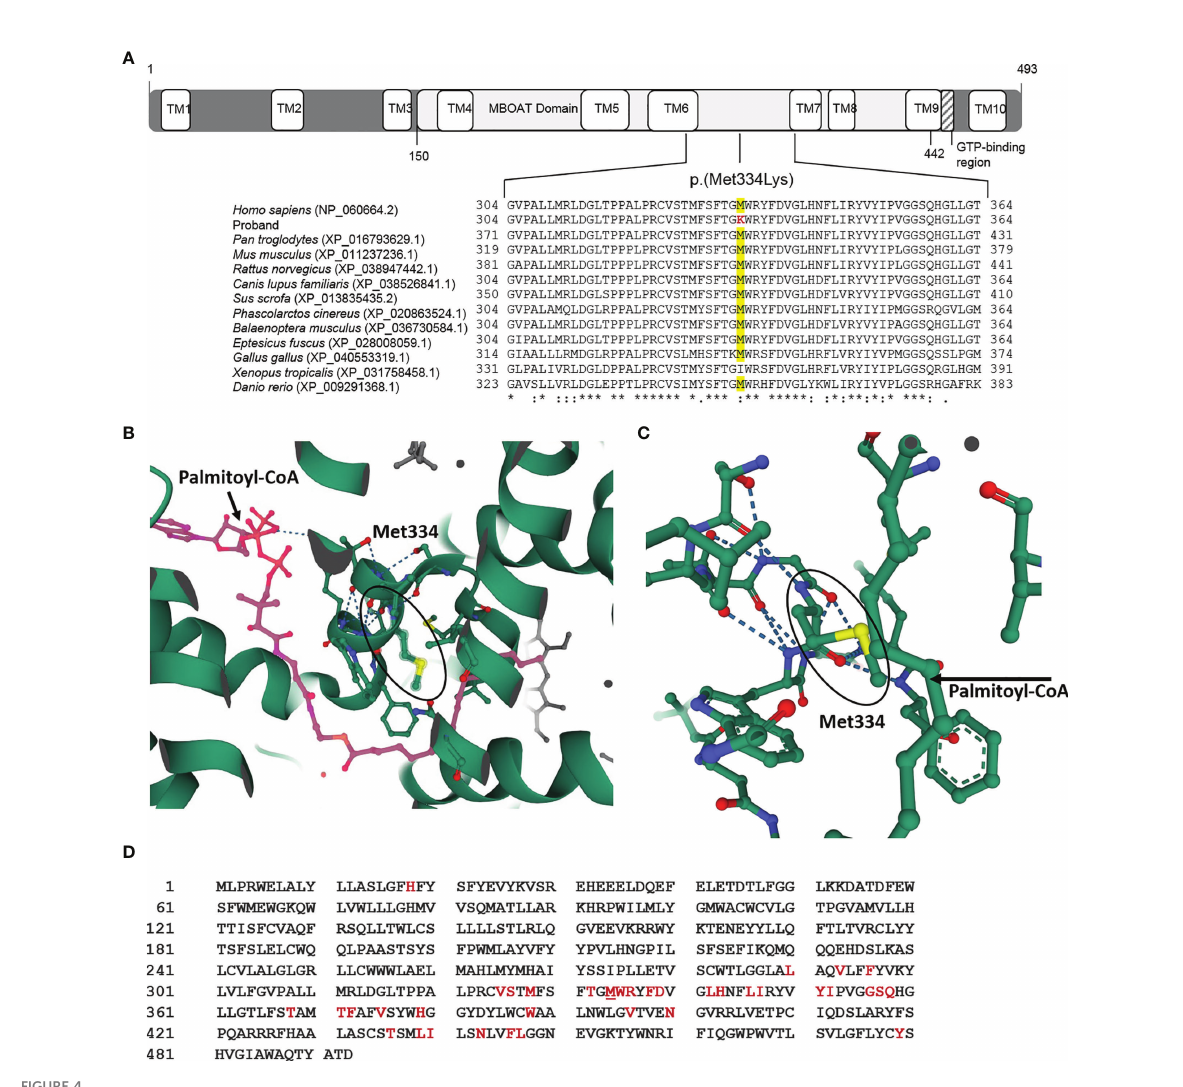
FIGURE 4 HHAT p.(Met334Lys) variant in silico studies. (A) Diagram of the HHAT protein isoform NP_060664.2 with its different domains and localization of variant p.(Met334Lys) in membrane-bound O -acyltransferase (MBOAT) functional domain of the protein. The in silico studies using Clustal Omega showed that the mutated Methionine 334 is conserved through vertebrates. (B) 3D image of the HHAT molecule and the ligand palmitoyl-CoA (in pink) indicating the position of Met334 (PBD 7MHY, RCSB PDB). (C) 3D magni fi ed image indicating that the 334 position is very close to the ligand palmitoyl-CoA. (D) HHAT peptide sequence showing the amino acids in the active center (<8 Å from the ligand) (in red), which includes Met334